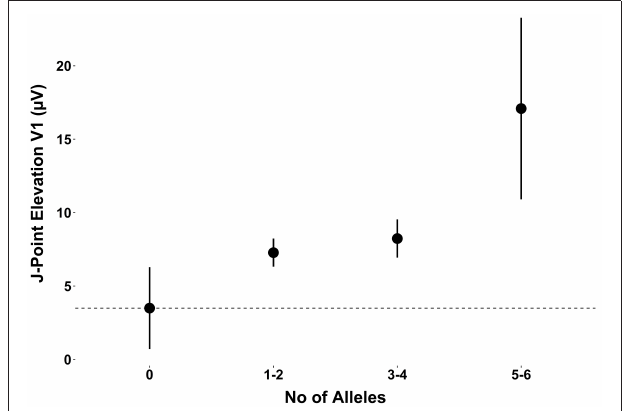
FIGURE 3 | The additive effect of carrying multiple BrS-associated risk alleles on the JPE in lead V1 for males and females. JPE (mean ± SE) as a function of number of risk alleles ( SNC5A rs11708996, SCN10A rs6800541, HEY2 rs9388451). JPE, J-point elevation; SNP, single nucleotide polymorphism.